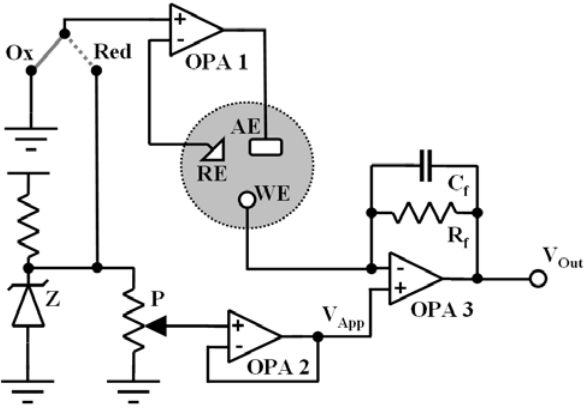
Figure 4. Amperometric section of the biotelemetric device. Ox: Oxidation; Red: : Feedback Reduction; Z: Zener diode; P: Potentiometer; OPA: Operational Amplifier; R f Resistor; C : Feedback Capacitor; V : Applied Potential; V : Output Voltage; WE: f App Out Working Electrode; RE: Reference Electrode; AE: Auxiliary Electrode.